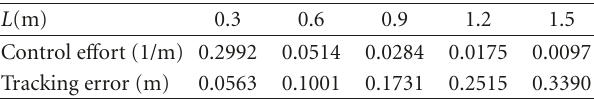
Table 1: Influence of the lookahead distance for wall following. L (m) 0.3 0.6 0.9 1.2 1.5